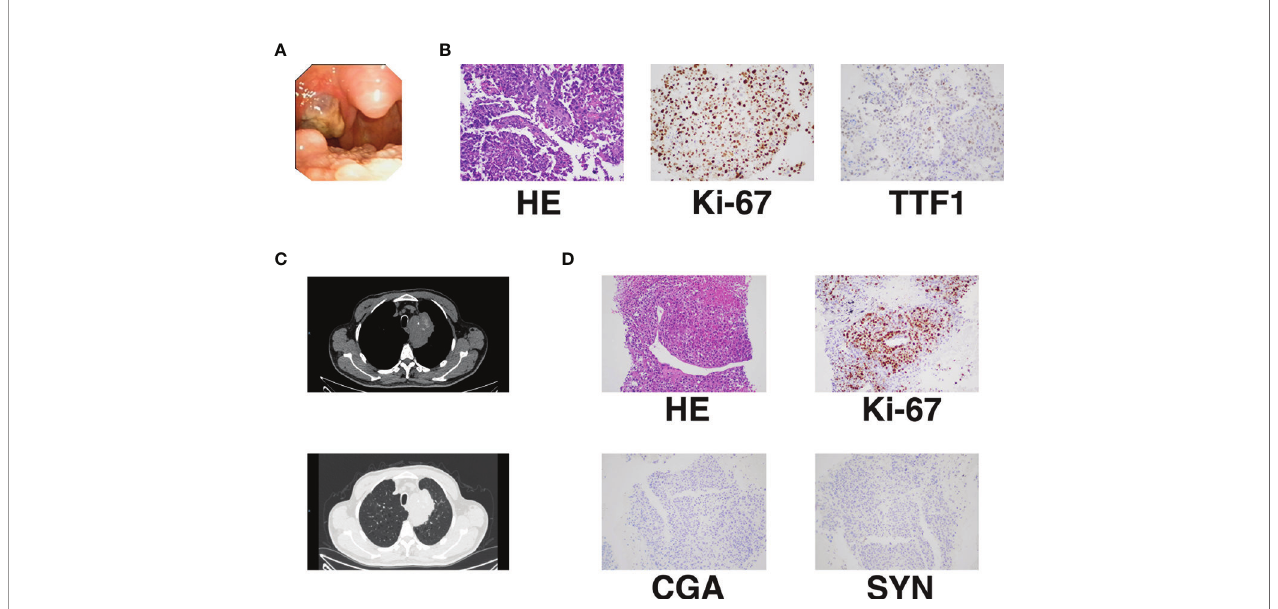
FIGURE 1 | Initial diagnosis of advanced undifferentiated large-cell lung cancer with rare tonsillar metastasis. (A) Tonsillar metastasis. (B) Pathology and immunohistochemistry of tonsillar metastasis [KI-67 (40%+); TTF1 (±)]. (C) Primary lung lesion shown by chest CT. (D) Pathology and immunohistochemistry of the primary lung lesion [KI-67 (50%+); CGA ( − ; SYN ( −